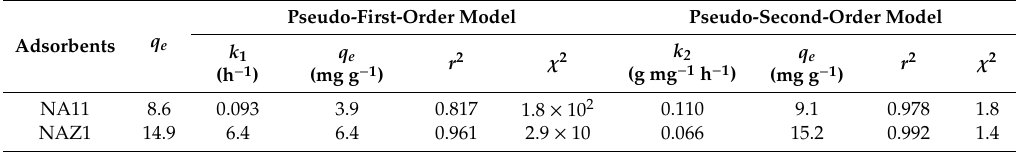
Figure 4. Effect of contact time on the adsorption of As(III) using NA11 and NAZ1. Initial concentration 100 mg L −1 , solvent volume 50 mL, adsorbent 0.1 g, contact time 0.5, 1, 3, 6, 9, 12, 16, 20, Table 2. Kinetic parameters for the adsorption of Table 2. Kinetic parameters for the adsorption of As(III).